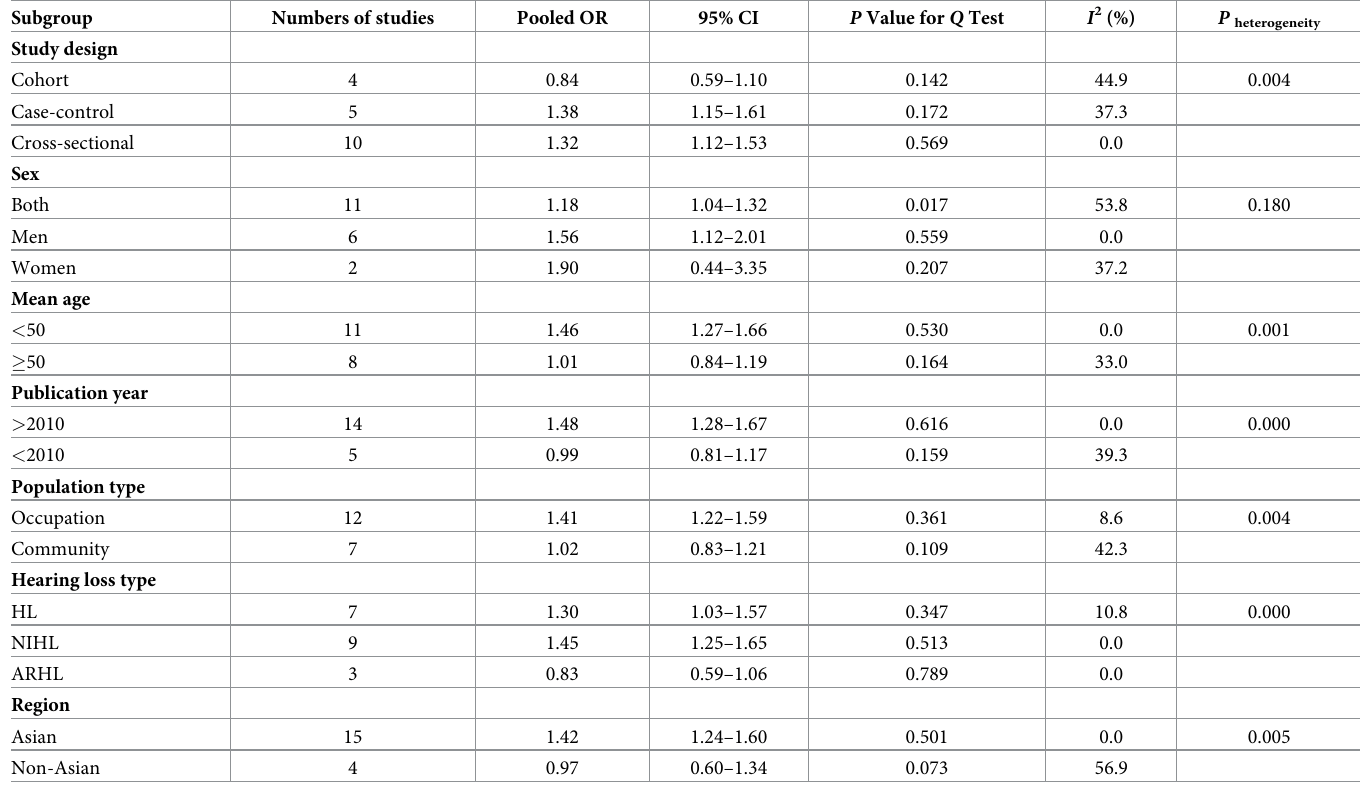
Table 2. Subgroup analyses relating alcohol consumption and hearing